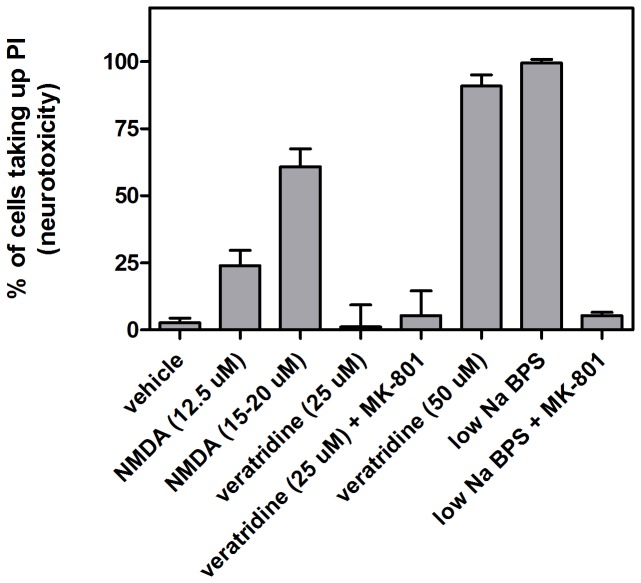
Effects of agonist treatment and hypotonic solution on neurotoxicity.Neurotoxicity was assessed using % PI-uptake 24 h after treatment. Neuronal cultures were exposed as per bar diagram labels for 20 min for NMDA and veratridine and for 10 min for low Na BPS. MK-801 prevented PI-uptake related to NMDA channel activation, both during NMDA-treatment and during low Na+ induced neuronal swelling. In the latter case, neurotoxicity was presumably a secondary consequence of swelling-induced glutamate release (and hence, of hyper-activation of NMDA channels). Error bars are standard deviations based on n = 6-9 for each treatment.